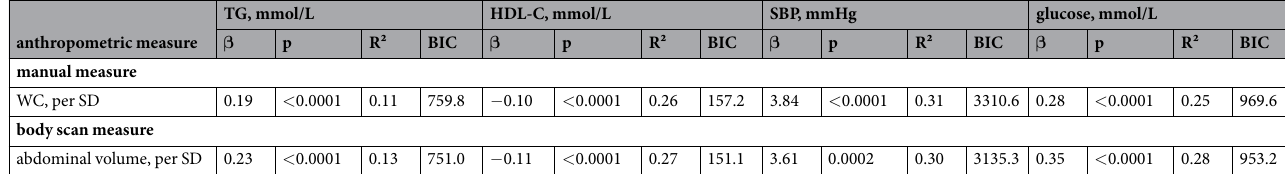
Table 3. Association of manually measured waist circumference and body scanner-based abdominal volume with parameters of the Metabolic Syndrome, total (N = 411) 1 . BIC, Bayes Information Criterion; HDL-C, high-density lipoprotein cholesterol; SBP, systolic blood pressure; SD, standard deviation; TG, triglycerides; WC, waist circumference 1 Results were derived from eight different multivariable linear regression analyses with either manually measured waist circumference or body scanner-based abdominal volume included as independent variable. Parameters of the Metabolic Syndrome were included as single dependent variable. β -coefficients can be interpreted as absolute difference in the parameters of the Metabolic Syndrome, referring to one standard deviation difference in the anthropometric measure. Model adjusted for adjusted for sex, age, and body height (manual measurement).